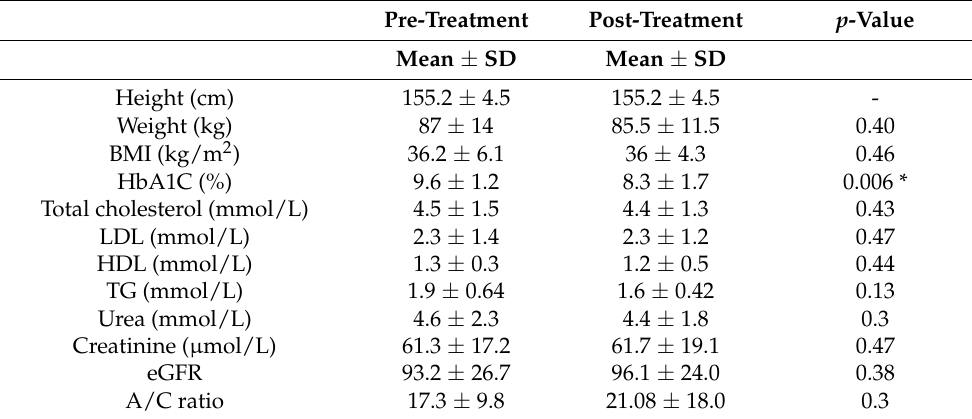
Table 1. Clinical and biochemical characteristics of the study population before and after liraglutide treatment. Pre-Treatment Post-Treatment p -Value Mean ±